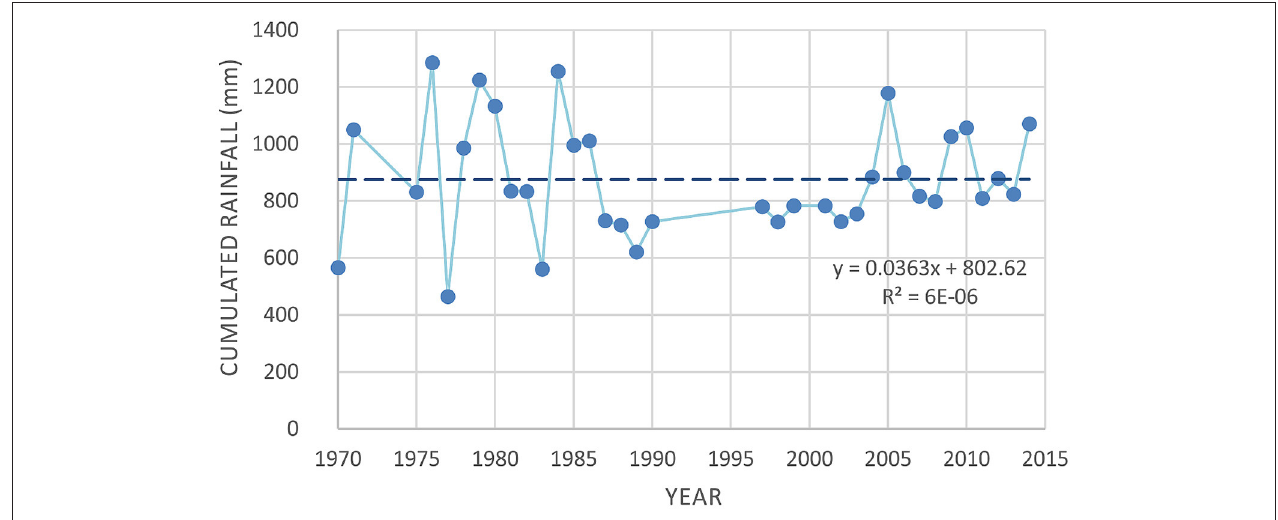
FIGURE 3 | Cumulated annual rain at the Pozzuoli rain gauge.